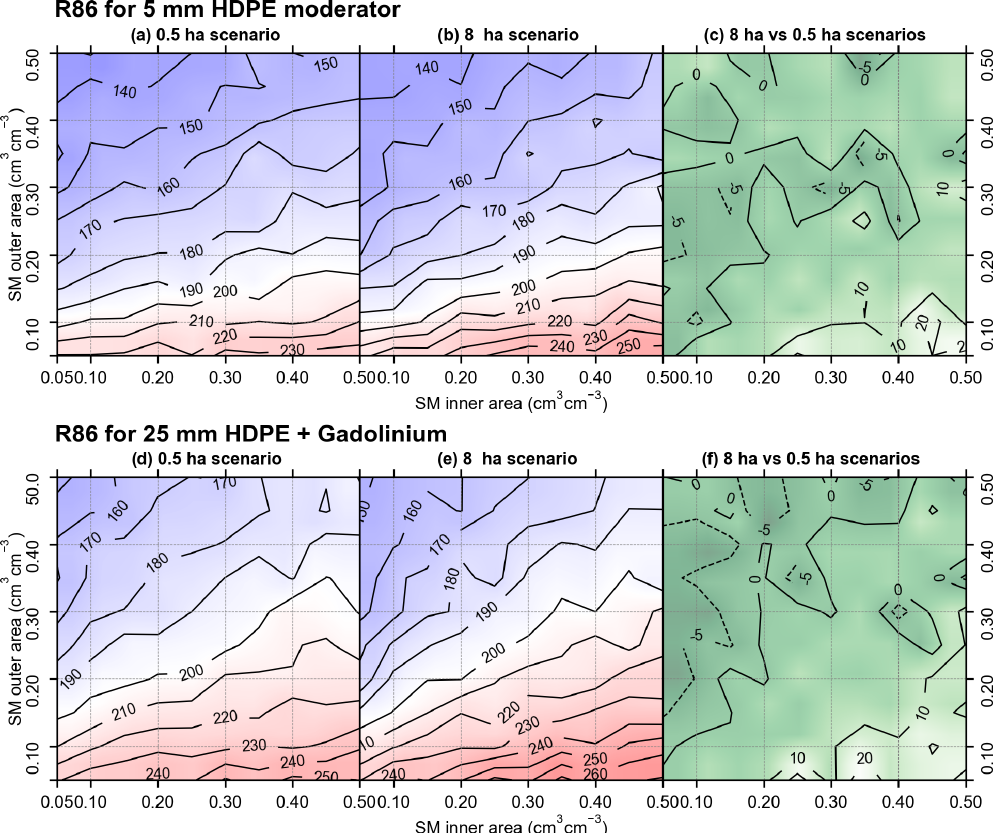
Figure 4. Variation in R86 with SM using a 5mm HDPE moderator for the (a) 0.5ha and (b) 8ha scenario and using a 25mm HDPE moderator with gadolinium shielding for the (d) 0.5ha and (e) 8ha scenario. The differences between the 8ha and 0.5ha scenarios are shown in (c) for the 5mm HDPE moderator and in (f) for the 25mm HDPE moderator with gadolinium shielding. Here, negative values indicate that the footprint of the 8ha scenario is smaller than that of the 0.5ha scenario and vice